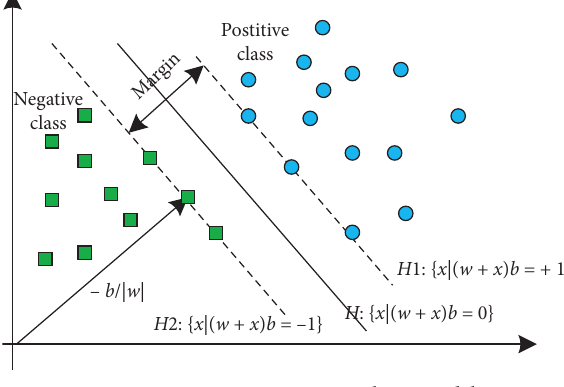
Figure 1: Support vector machine